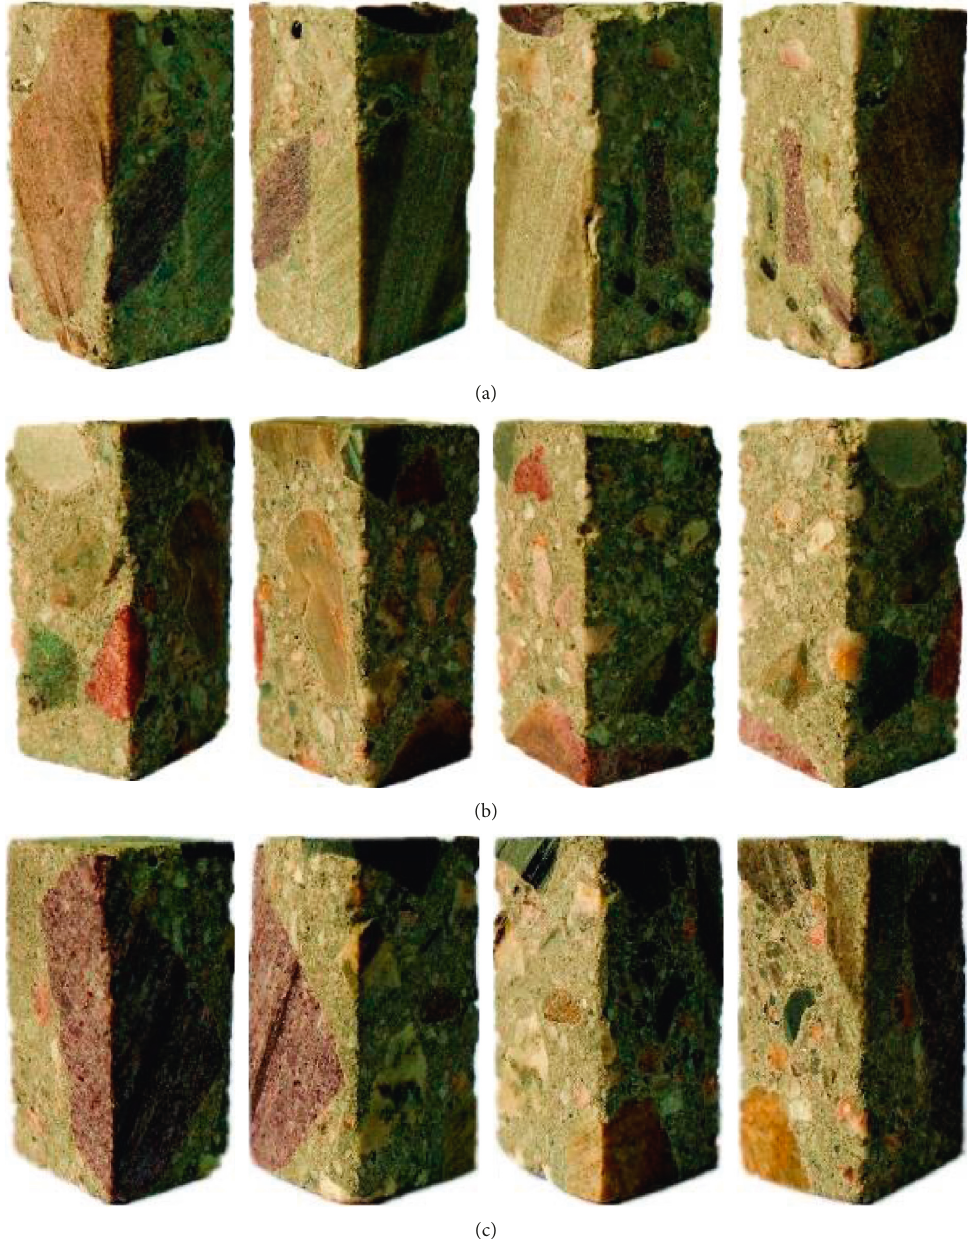
Figure 1: Original digital image of specimens. (a) Specimen S1. (b) Specimen S2. (c) Specimen